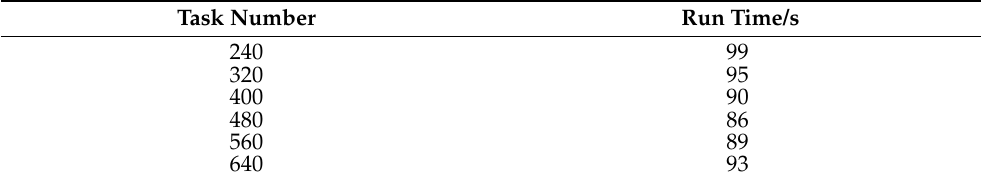
Table 2. Processing time of a single PATCH for different tasks with 8